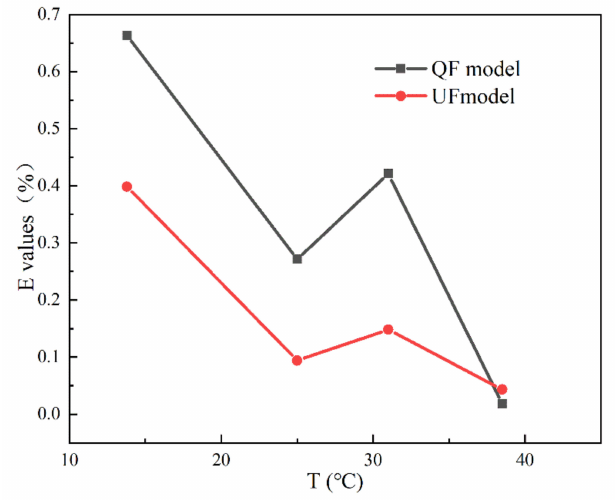
Figure 8. Comparison of dimensionless difference values at different water